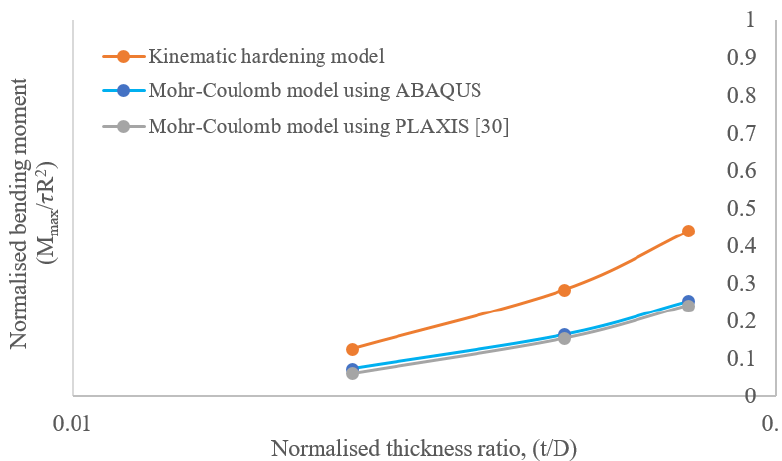
𝒕 𝟏 𝑫⁄ = 2), t 1 = 0.025, = 𝟐 ), = D D 𝑫